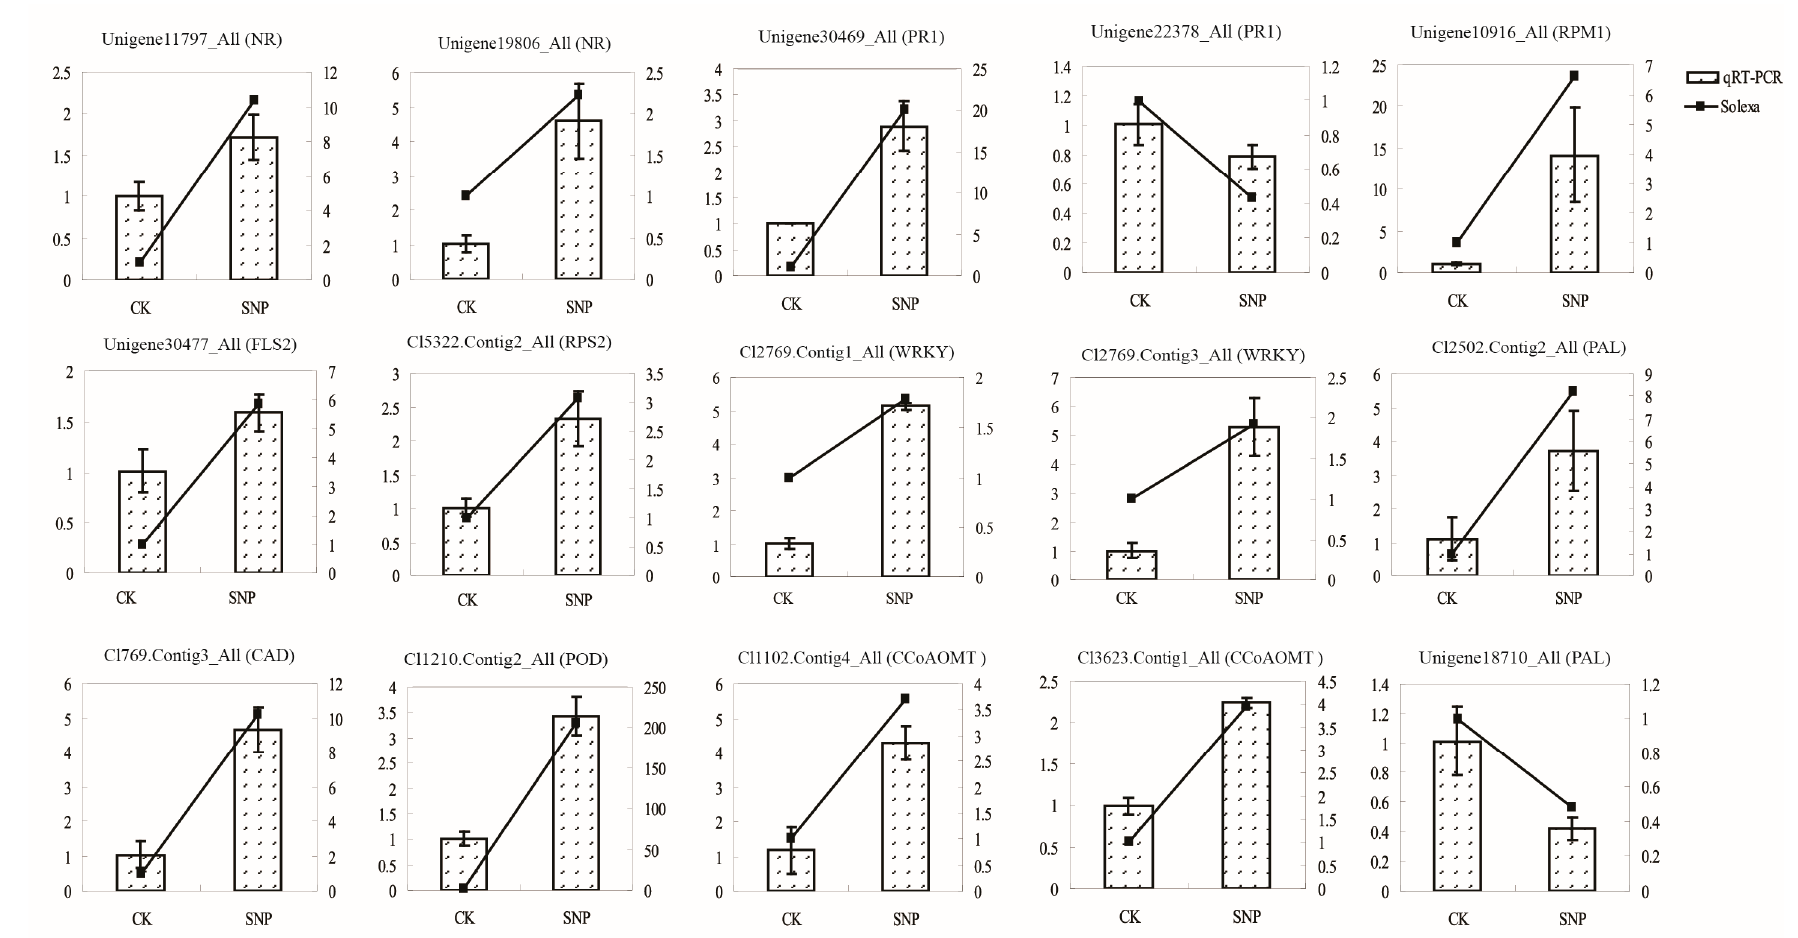
Figure 6. QRT-PCR analysis of selected genes. Fifteen genes were selected to verify the transcriptomic data. The histogram represents qRT-PCR analysis and the line chart represents RPKM (Reads per Kilobase of exon model per Million mapped reads) values. The X -axis stands for different samples. The right Y -axis stands for relative expression level and the left Y -axis indicates RPKM values. Standard deviations were derived from three replicates of each experiment.